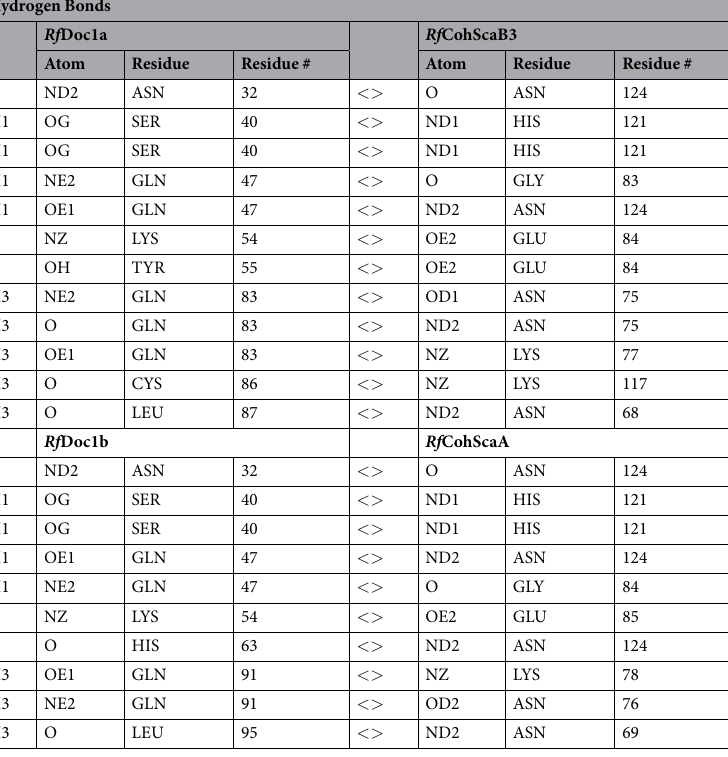
Table 1. Main polar contacts between Rf CohScaB3 and Rf Doc1a and Rf ScaACoh and Rf Doc1b. Table was made using the PDBePISA server and the contacts were further verified manually with Coot. Some of the dockerin residues are marked as belonging either to helix 1 (H1) or to helix 3 (H3)